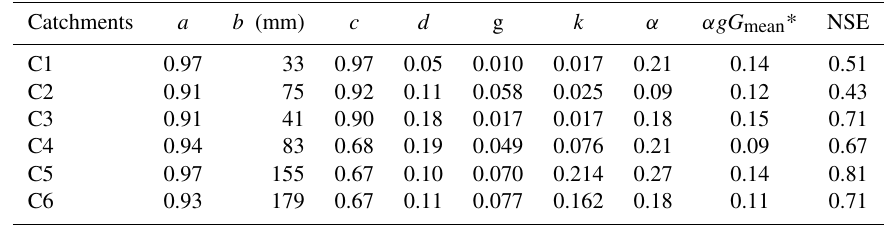
Table 3. Best fitting parameters of the “natural” models for the study catchments.